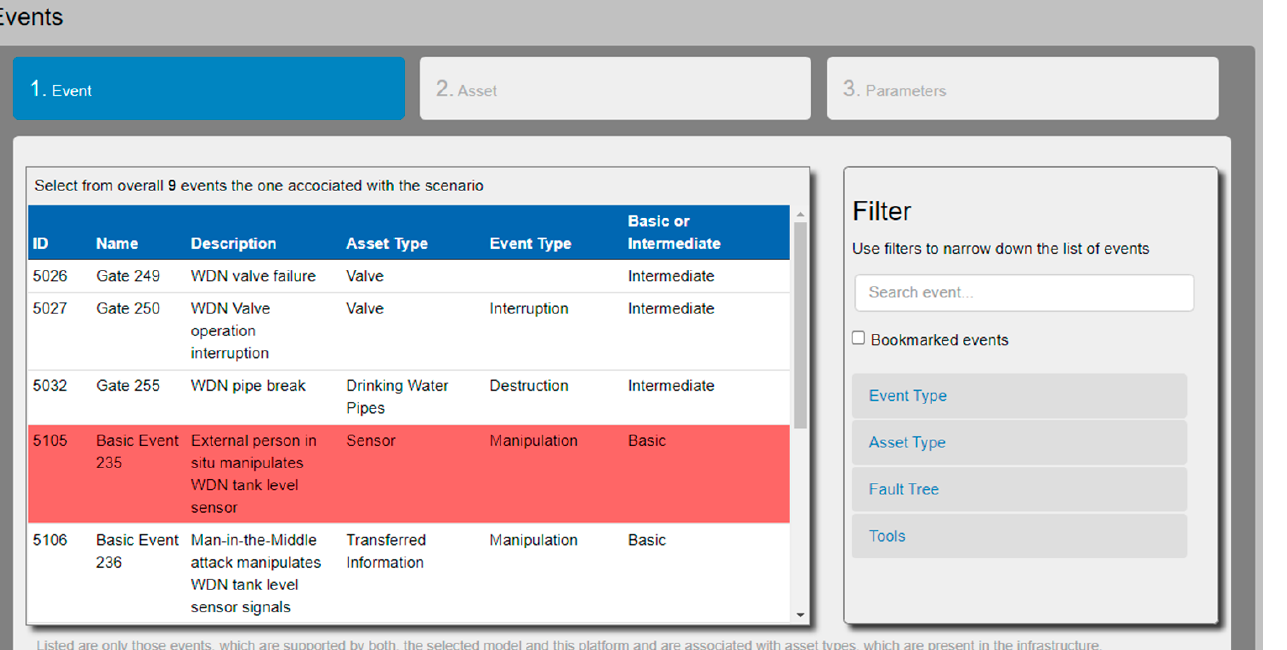
Figure 4. Unmet demand (m 3 /s) ( a ), nodes out of service [ − ] ( b ), and customer minutes lost (as indi- cated, values on y -axis are scaled by 10 3 ) (min) ( c ), derived from the KPI tool for RS 1.